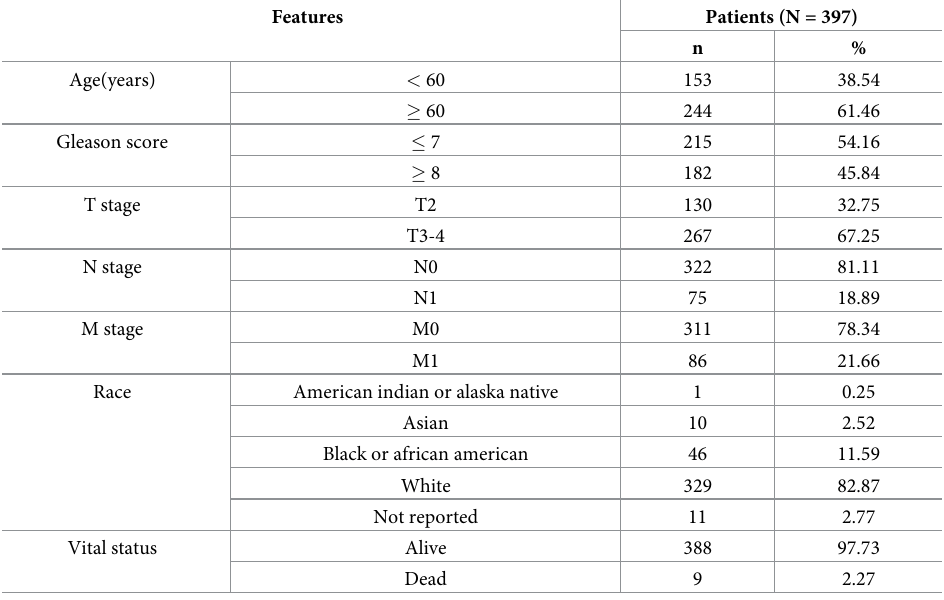
Table 1. PCa patients from TCGA database clinicopathological